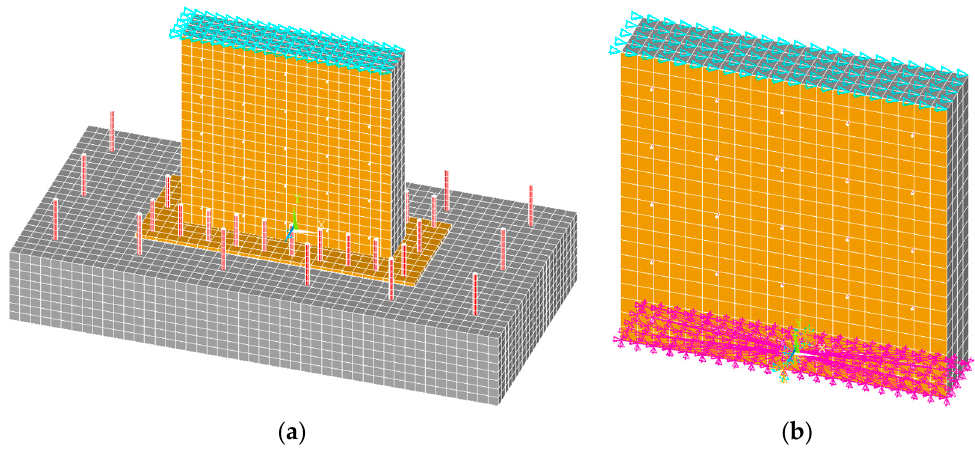
Figure 8. Computational model finite element grid, loading and support conditions ( a ) Detailed model; ( b ) Simplified model.